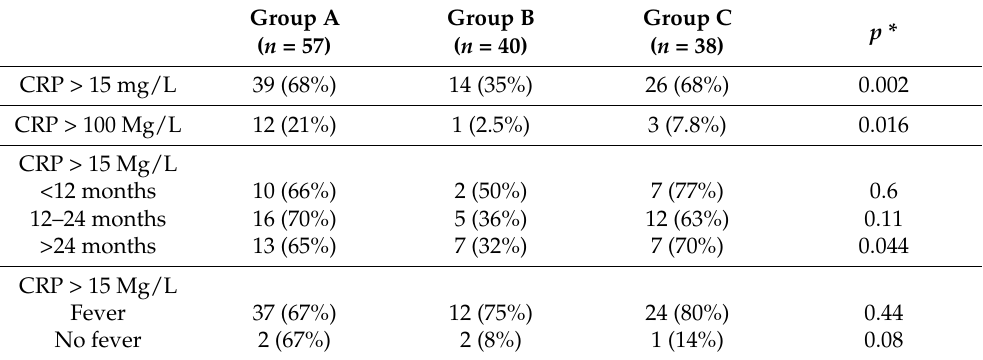
Table 5. The characteristics of CRP levels among